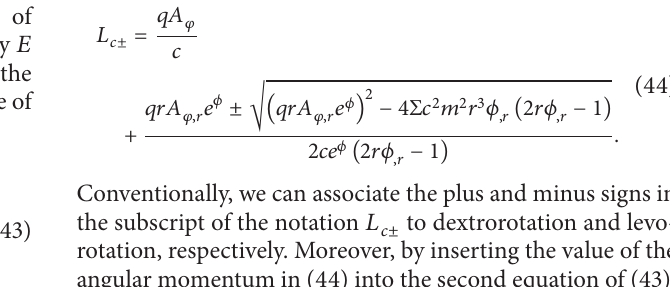
1/2 . Consequently, 𝐸 + = −𝐸 − = eff